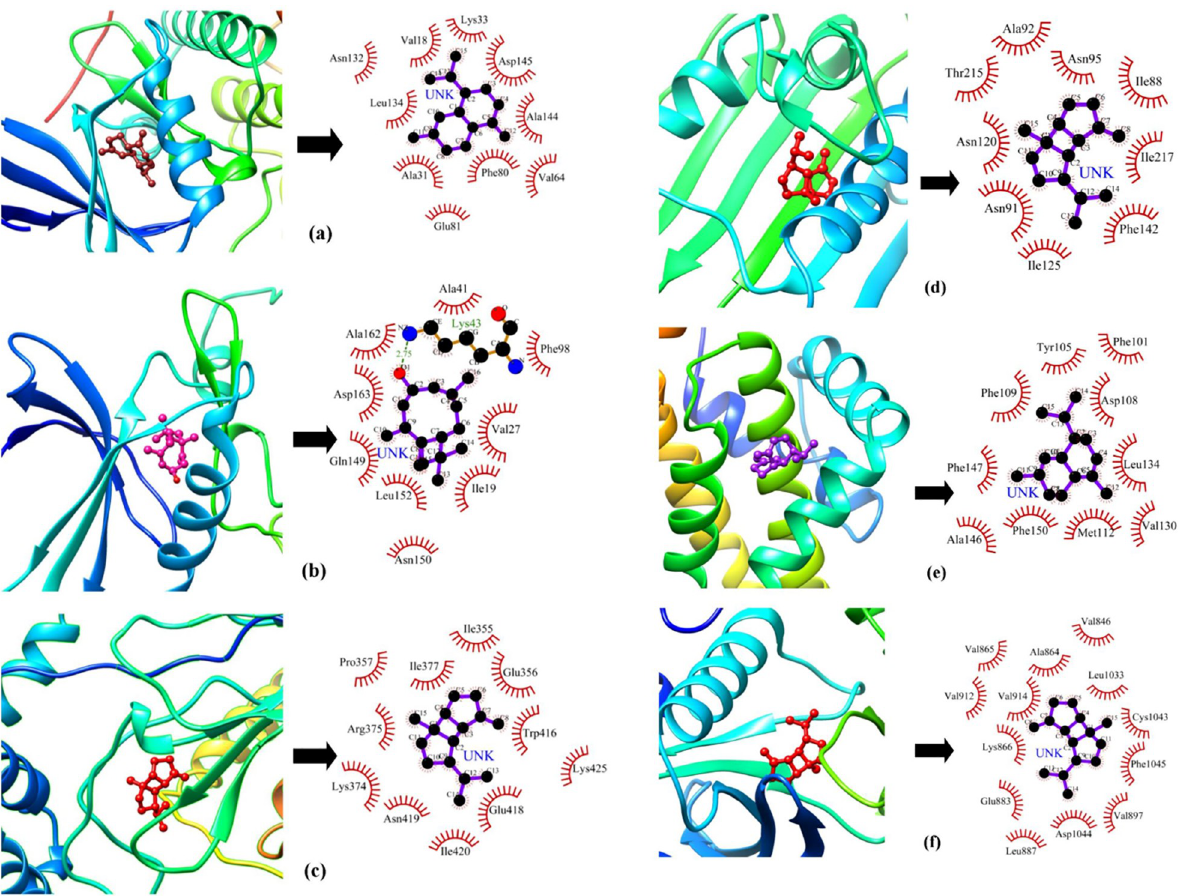
Fig 2. Binding modes and LigPlot+ results of best docked molecules with their target receptors- (a) CDK-2_comp44 ( b) CDK-6_comp59 (c) Topo I_comp37 (d) Topo II_comp37 (e) Bcl-2_comp46 (f) VEGFR-2_comp37. The hydrogen bonds are indicated by green dashed lines with the bond distance, and the residues contributing to hydrophobic interactions are represented with red arcs with